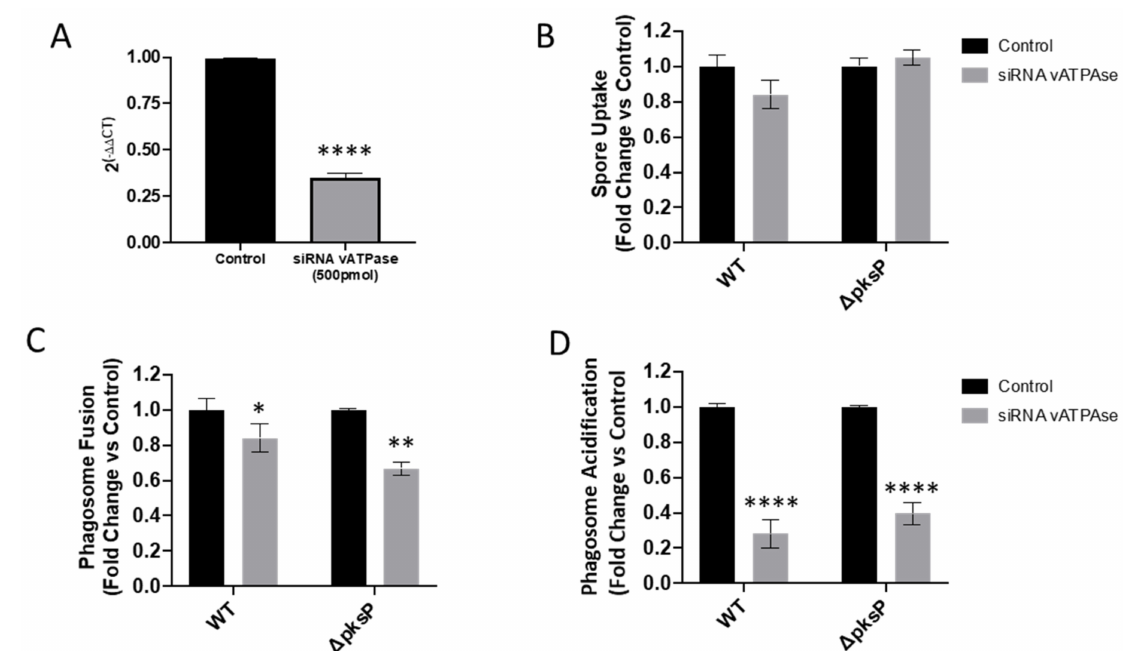
Figure 7. Impact of vATPase siRNA silencing of A549 alveolar epithelial cells in ( A ) vATPAse gene expression, ( B ) A. fumigatus spore uptake, ( C ) phagolysosome fusion and ( D ) phagosome acidification by A549 and 16HBE cells at 3 h post infection. Asterisks represent differences vs. control. Data shown as mean ± standard deviation of three biological and technical triplicates (* p < 0.05, ** p <0.01, **** p